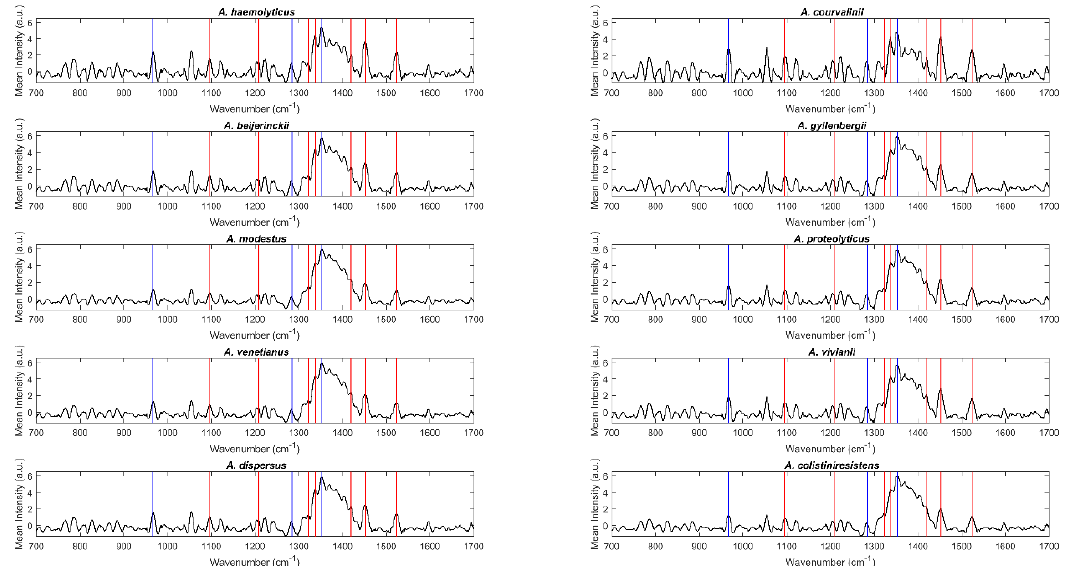
Figure 1. Mean Raman spectra of Acinetobacter spp. belonging to the Acinetobacter baumannii - Acinetobacter calcoaceticus complex. Blue and red vertical lines correspond to peaks attributed to agar and bacterial component vibrations, respectively.